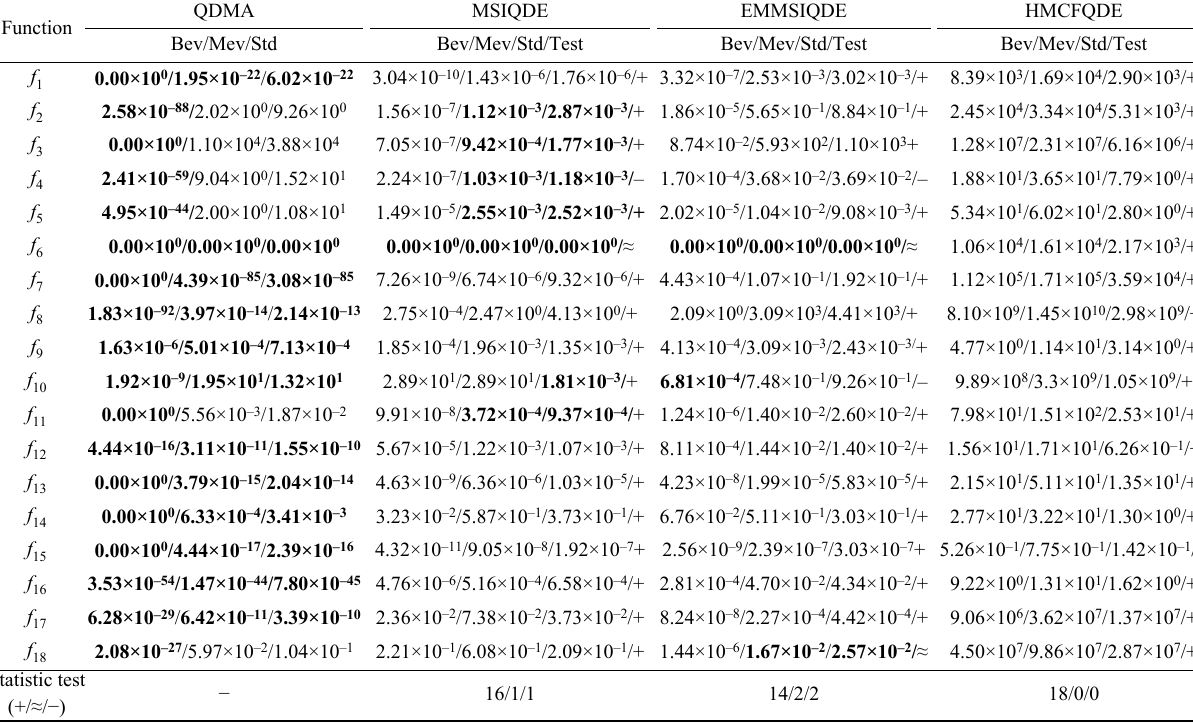
Table 2 Comparison of QDMA and state-of-the-art QEAs on 30 D problems.